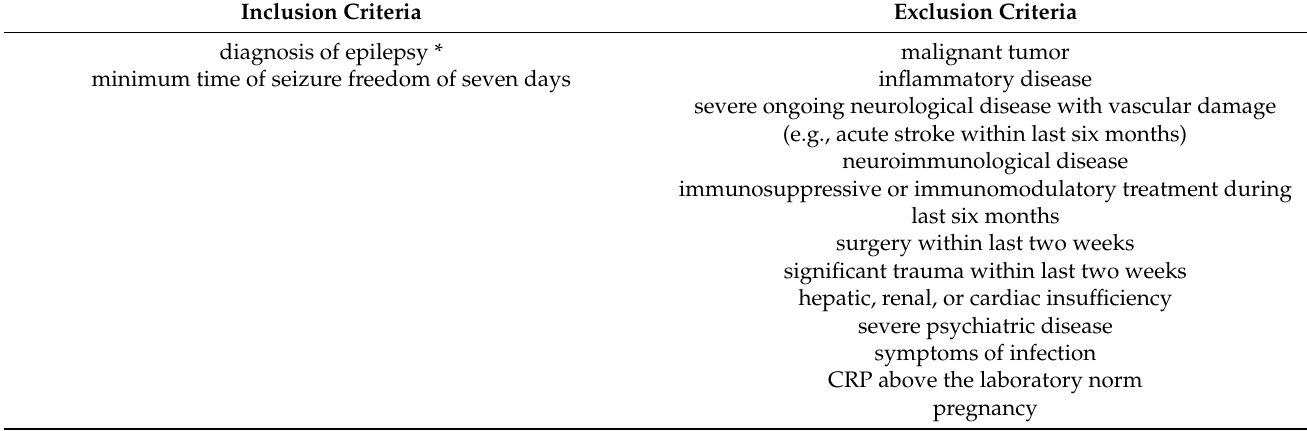
Table 1. Inclusion and exclusion